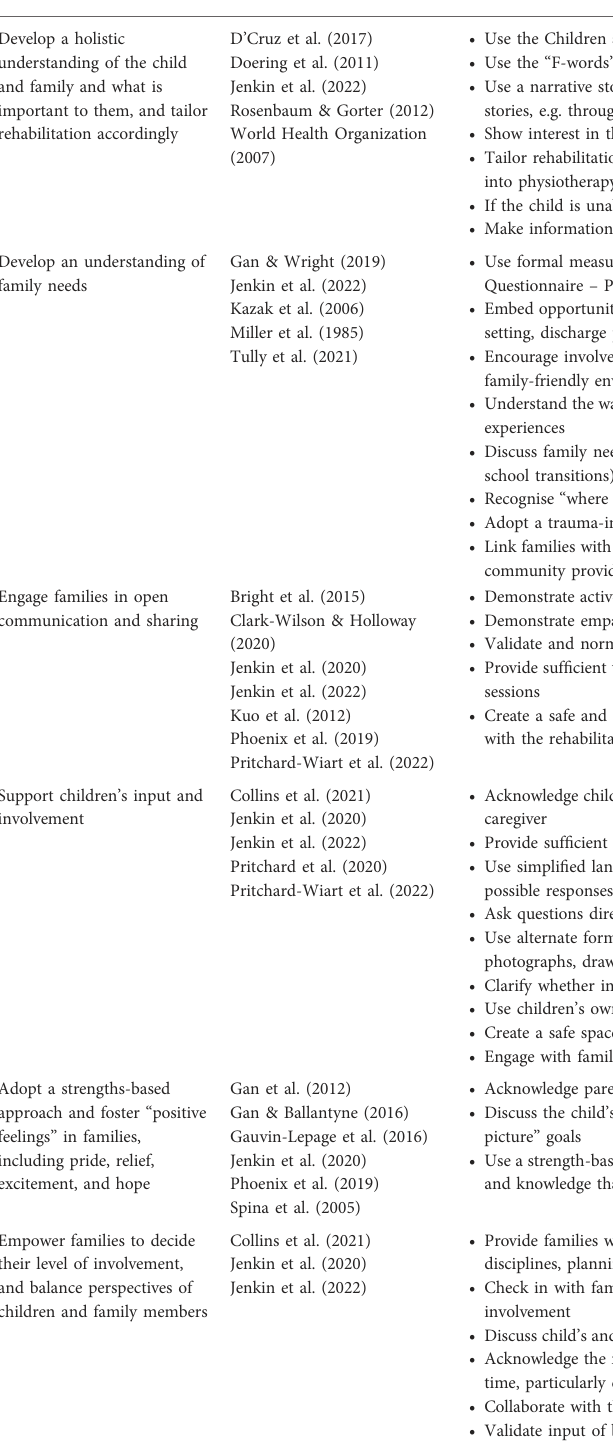
TABLE 1 Key recommendations and actions for